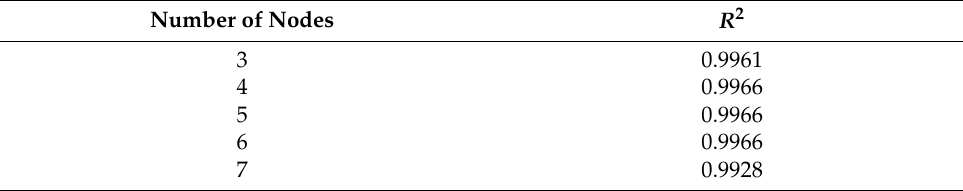
Table 19. R 2 of the neural network with different nodes in the hidden